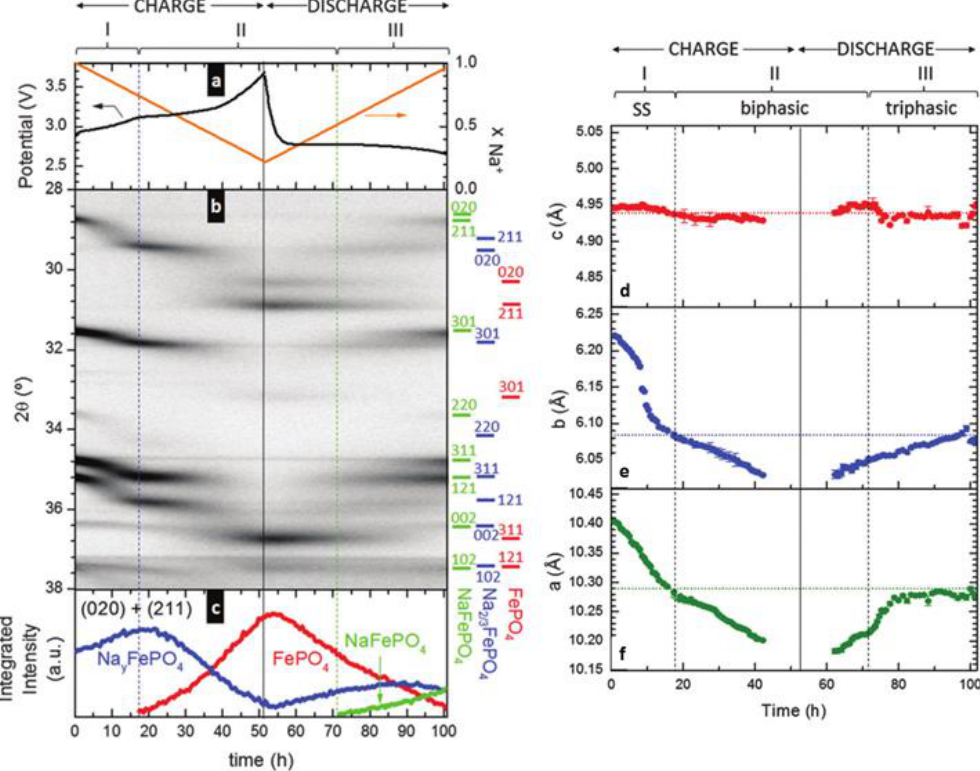
Figure 5. ( a ) Voltage and Na + content versus time. ( b ) 2 θ versus time plot of the XRD patterns of a full charge-discharge cycle. The grey level is proportional to the relative intensity. Horizontal bars at the right indicate the position of the Bragg peaks for each of the phases. ( c ) Sum of the integrated intensity of the (020) and (211) reflections for each of the phases versus time. ( d – f ) The evolution of the cell parameters of Na x FePO 4 during cycling. The dotted horizontal lines indicate the cell parameters of the chemically synthesized Na 2/3 FePO 4 . The solid vertical line indicates end of charge, the two dashed vertical lines separate regions with different mechanisms [148]; with permission from RSC publishing. Two voltage plateaus, separated by a voltage step at Na + ~ 0.7, are seen on charge, whereas only one plateau is evident on discharge. Figure 5b is the image plot of the XRD spectra with (hkl) of the phases participated labelled on the right axis. At the initial stage of charge, a continuous shift of the NaFePO 4 peaks, mostly to the high two theta direction, is observed, which is an indication of a solid- solution reaction; with further extraction of Na ions to Na + ~ 0.7, a new intermediate phase forms, with sodium content ~ 0.7 and is identified as Na 2/3 FePO 4 [149]. Continuing the extraction of Na + , FePO 4 peaks appear and grow at the expense of the intermediate phase of Na 2/3 FePO 4 until the end